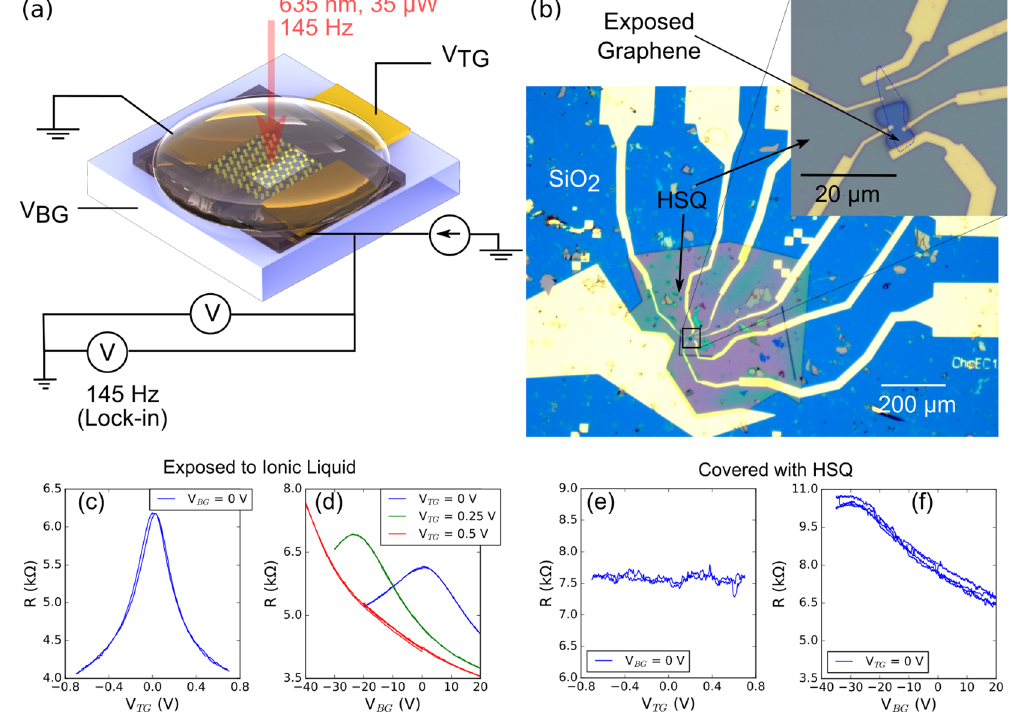
Figure 2. Optical image and resistance measurements. (a) Schematic of a graphene device which is gated both electrostatically and electochemcically and the measurement circuit with simultaneous measurement of resistance and photovoltage. (Supplementary Section VIII). (b) Optical image of the graphene device on which measurements have been performed. The substrate is silicon with 300 nm of silicon dioxide. Source and drain electrodes, and a top gate electrode which is large in comparison with graphene, are made from titanium and gold. The graphene flake is partially masked with 500 nm thick HSQ. The ionic liquid drop is small and does not touch the aluminium wire bonds. (c , d , e , f) Resistance measurements as a function of top gate and back gate voltages at 280 K measured separately for the exposed and covered regions. (c) and (d) Resistance variation with the top gate and back gate in the region exposed to the ionic liquid. This region is influenced by both the gates. (e) and (f) Resistance variation with the top and back gates in the region covered with HSQ. The absence of gating with the top gate shows that HSQ is able to shield part of the graphene